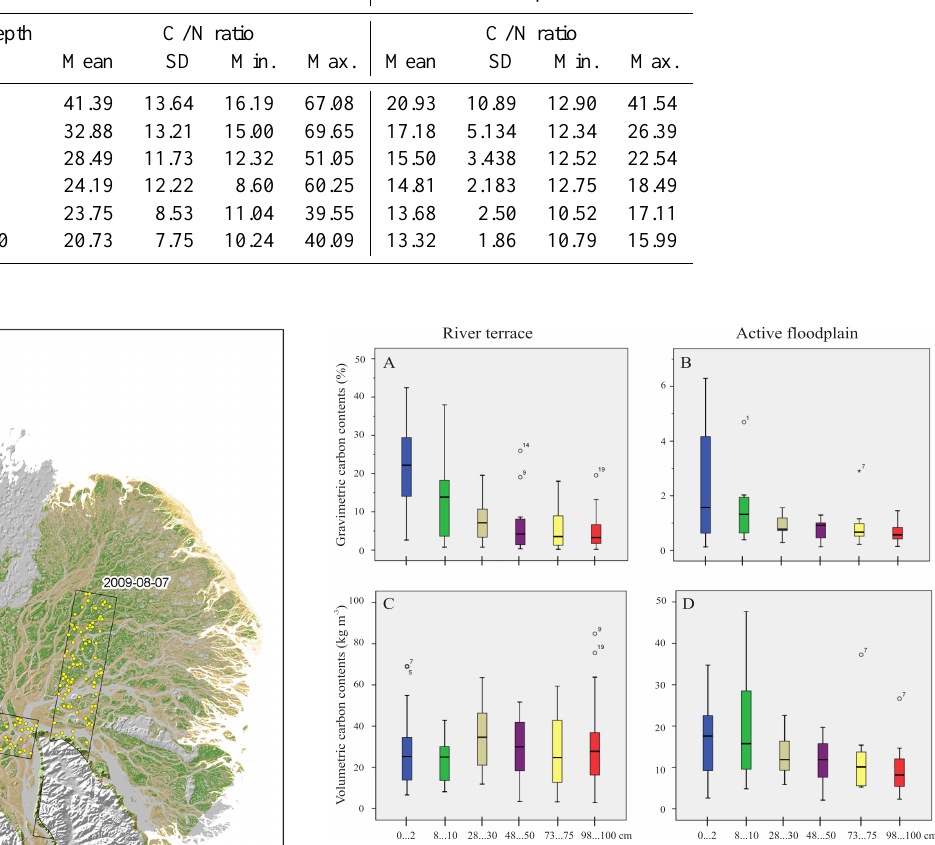
Table 4. Results of the C/N ratio determination for all six investigated soil depths and both geomorphic units, the Holocene river terrace and the active floodplain levels, with the mean values and the respective standard deviations as well as the minima and maxima. Holocene River Terrace Active Floodplain Levels